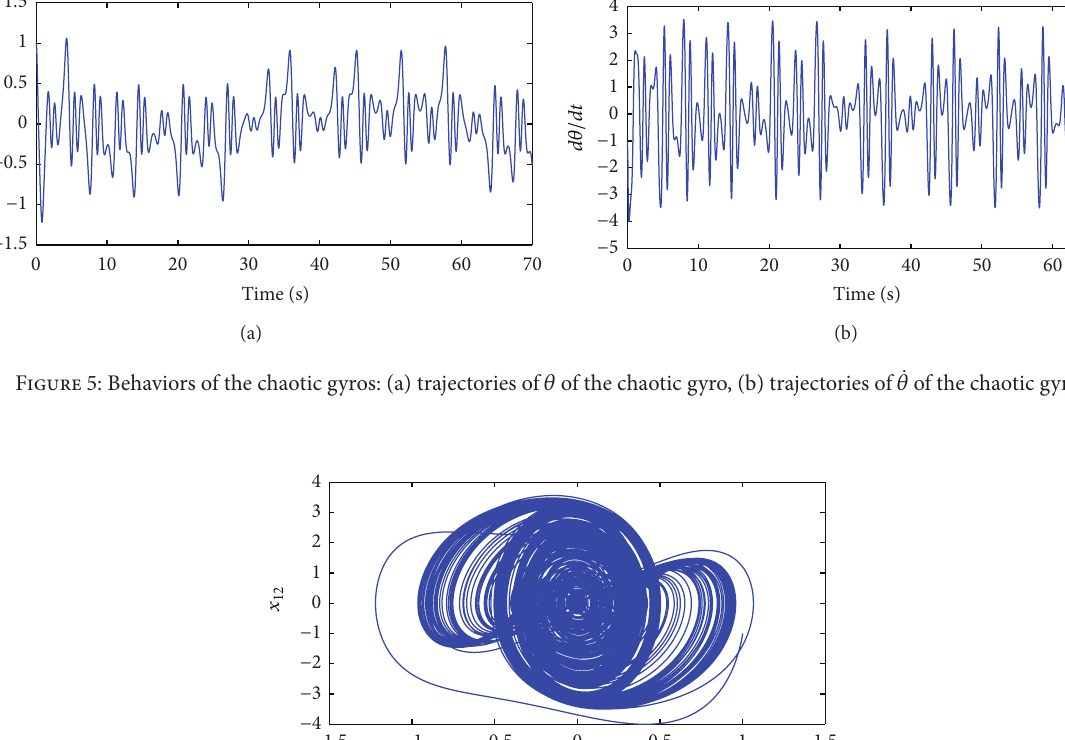
Figure 6: Phase portrait of the chaotic